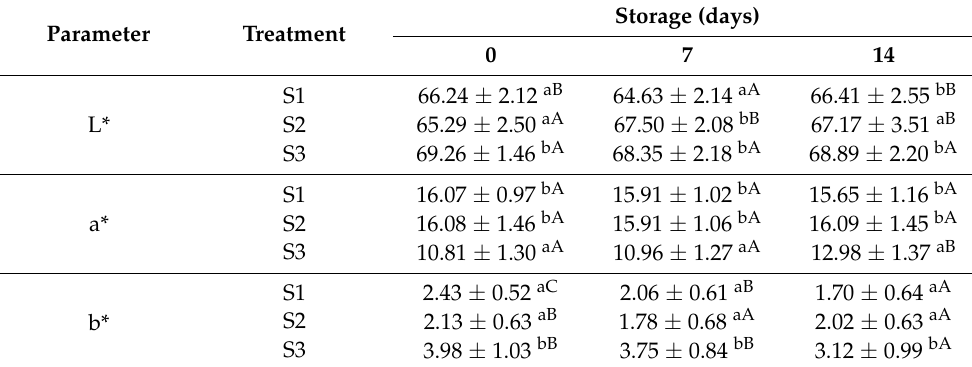
Table 3. Colour parameters in tested pork hams.